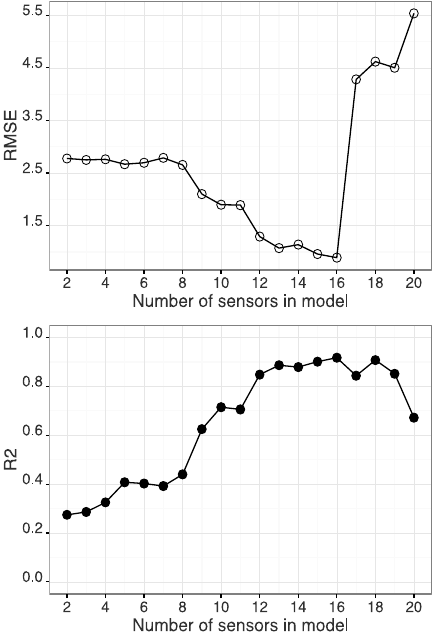
Figure 4. Evaluation of all sub-set of sensors (from two to 20) for glucose in the standard solutions with KCl (1 mol L − 1 ). Table 3. The sub-set of sensors selected and results for the multiple linear regression (MLR) model of each dependent variable. Mean Results of the K-Folds Results of the Best Cross-Validation MLR Model